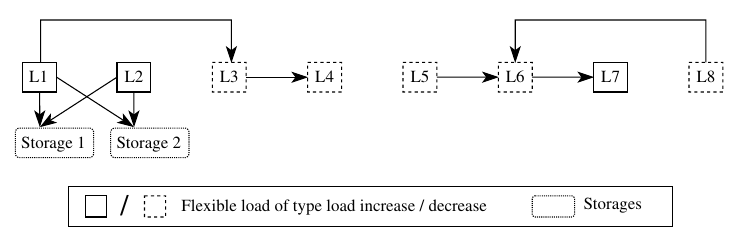
Fig. 6 Relationship between flexible loads and storages in use case III